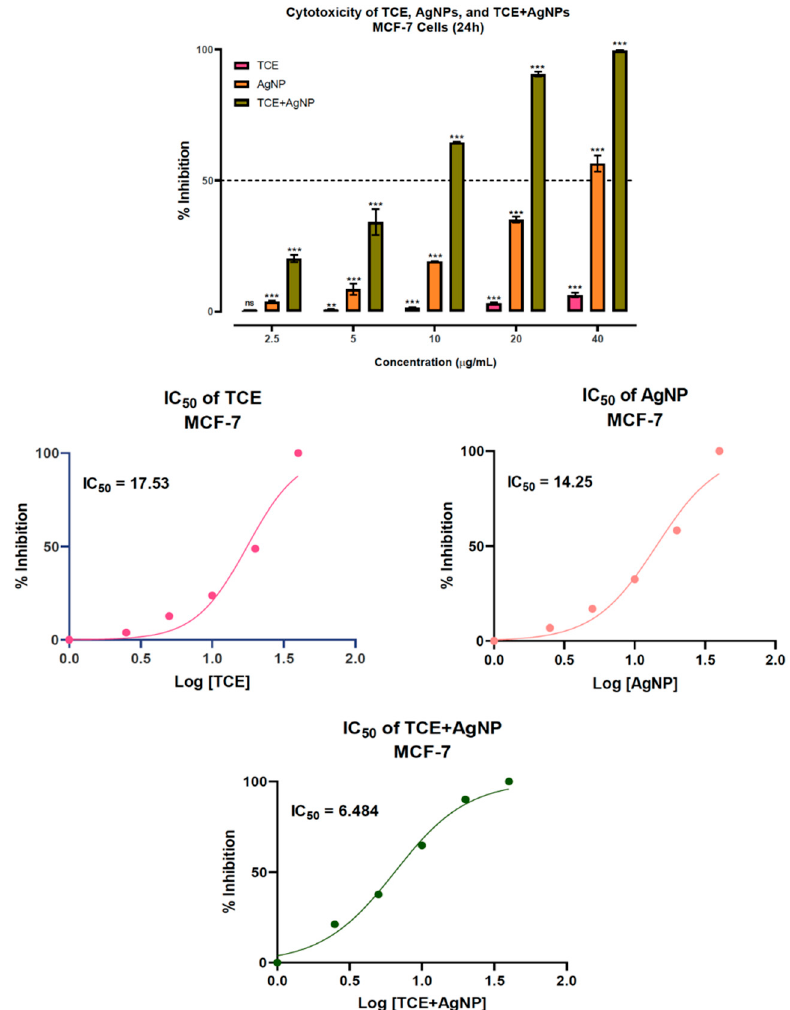
Figure 4. Cytotoxicity and IC 50 values of T. chebula extract (TCE), silver nanoparticles (AgNPs), and TCE-mediated silver nanoparticles (TCE + AgNPs) treatment on human breast adenocarcinoma (MCF-7) cells. ** p = < 0.002, *** p = < 0.001.